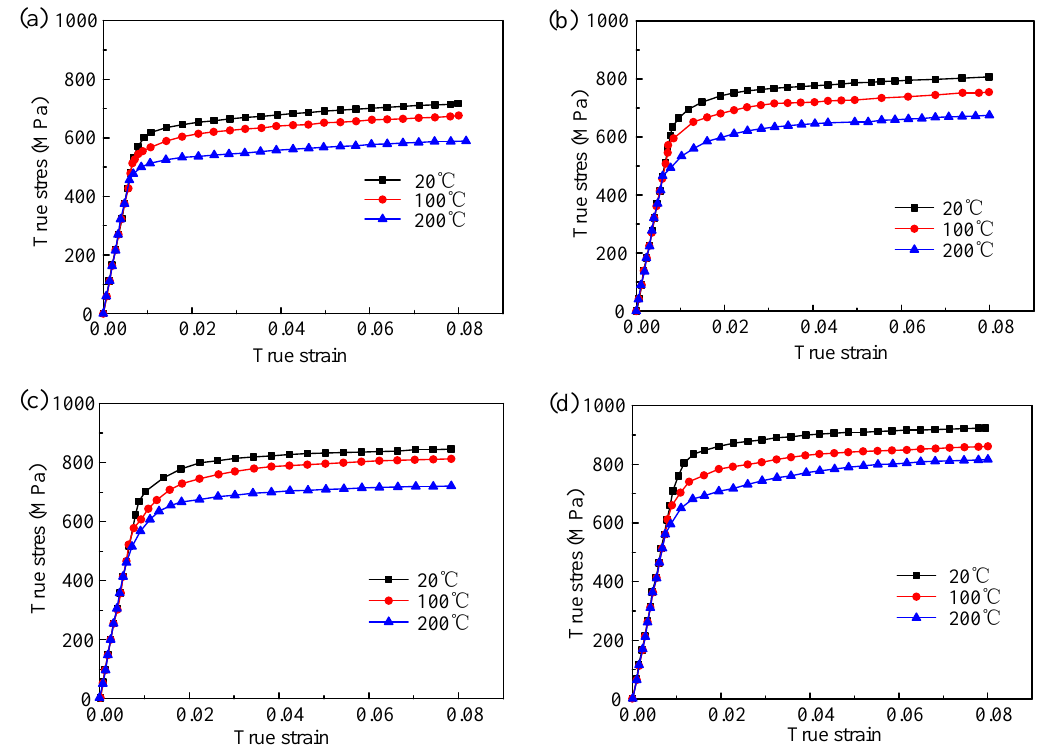
Figure 4. True stress – strain curves for TiB 2 /7050 composites under different temperature with the strain rate of ( a ) 0.001 s −1 , ( b ) 1000 s −1 , ( c ) 3000 s −1 , and ( d ) 5000 s −1 .